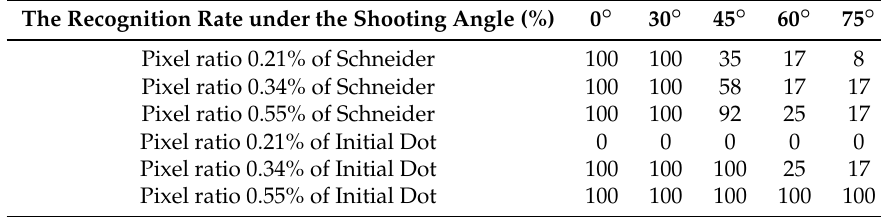
Table 2. Comparison coded points’